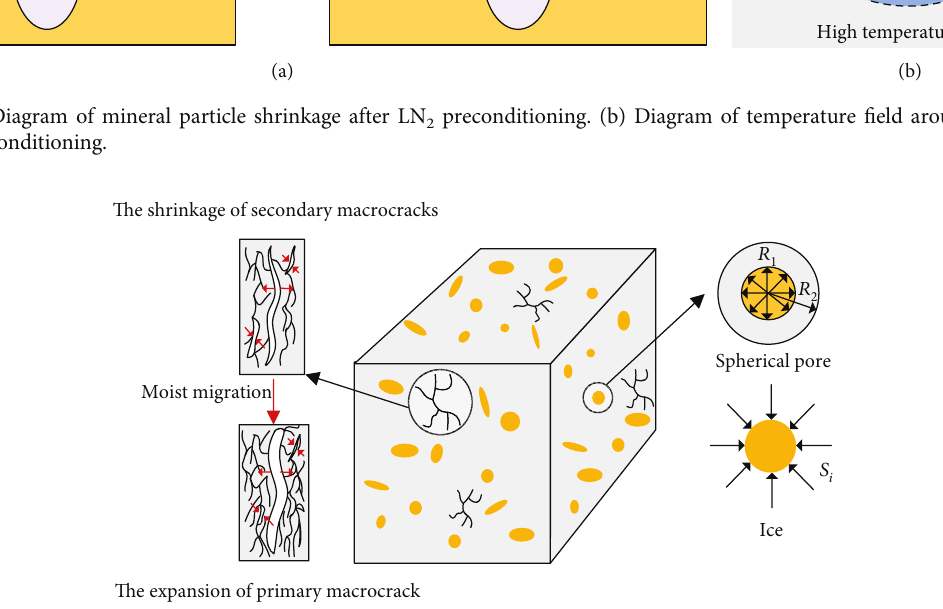
Figure 15: The propagation of spherical pore and primary macrocracks under frost heaving.